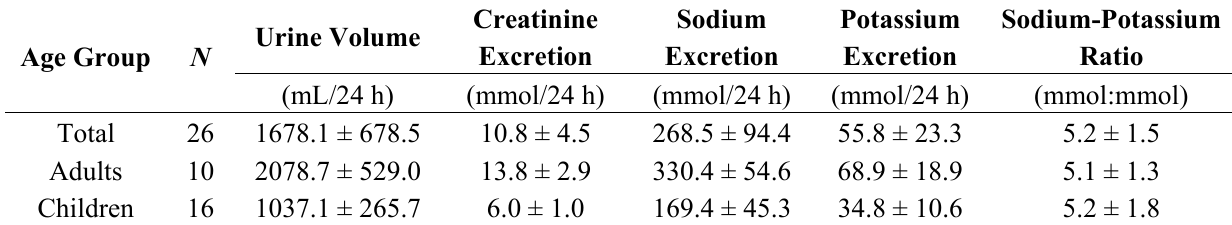
Table 2. Urine volume and excretion of creatinine, sodium and potassium by consecutive 7-day 24-h urine